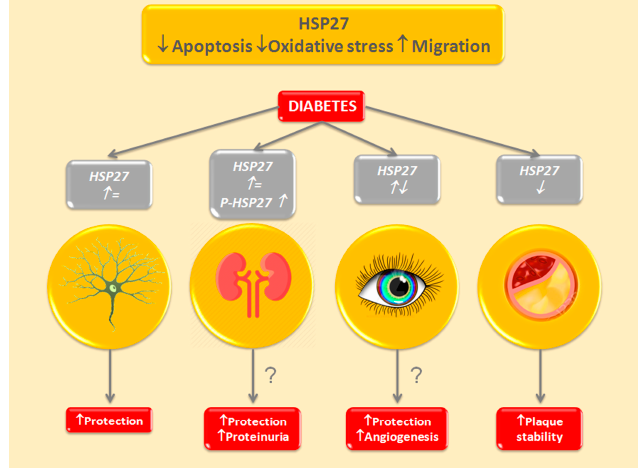
Figure 2. HSPB1/HSP27 in Diabetic Complications. HSPB1/HSP27 has anti-apoptotic and anti- oxidative effects and controls cell migration acting on the actin cytoskeleton. Expression of total and/or phosphorylated HSPB1/HSP27 (P-HSPB1/HSP27) is altered (up arrow: overexpressed; down arrow: downregulated) in target organs of diabetic complications (neurons, kidney, retina, vessel wall). HSPB1/HSP27 has neuroprotective effects and stabilizes atherosclerotic plaques. The role of HSPB1/HSP27 in diabetic nephropathy and retinopathy is undetermined; however, HSPB1/HSP27